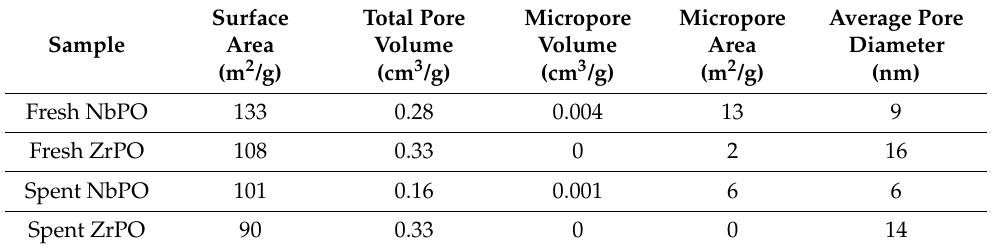
Figure 7. N 2 adsorption and desorption isotherms: ( A ) fresh NbPO, ( B ) fresh ZrPO, ( C ) spent NbPO, ( D ) spent ZrPO. Table 7. Texture properties of catalysts:fresh NbPO, spent NbPO, fresh ZrPO, spent ZrPO.